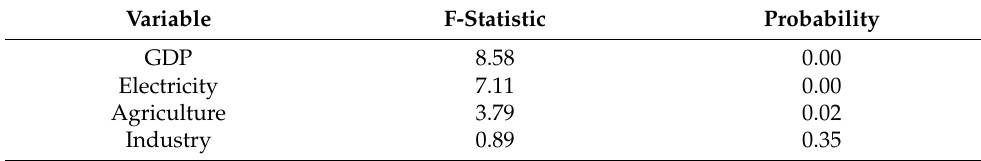
Table 5. Wald test for short-run causality towards CO 2 .